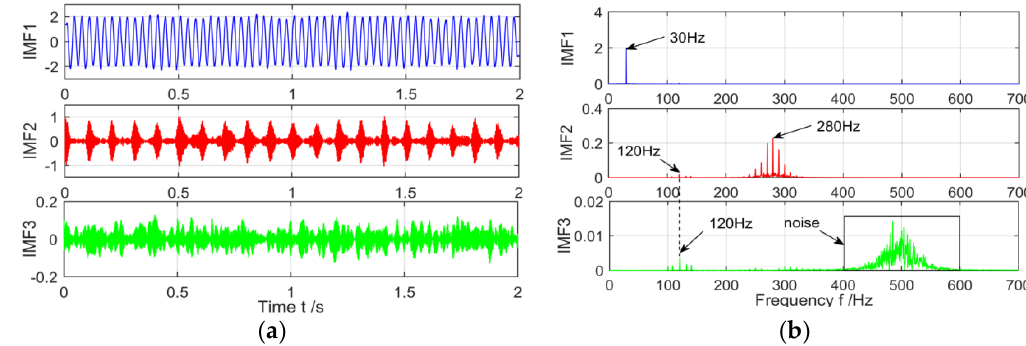
Figure 7. The spectrum of IMFs after VMD decomposition and its corresponding spectrum. ( a ) Time domain of IMFs after VMD; and ( b ) The spectrum corresponding to each layer of IMF.